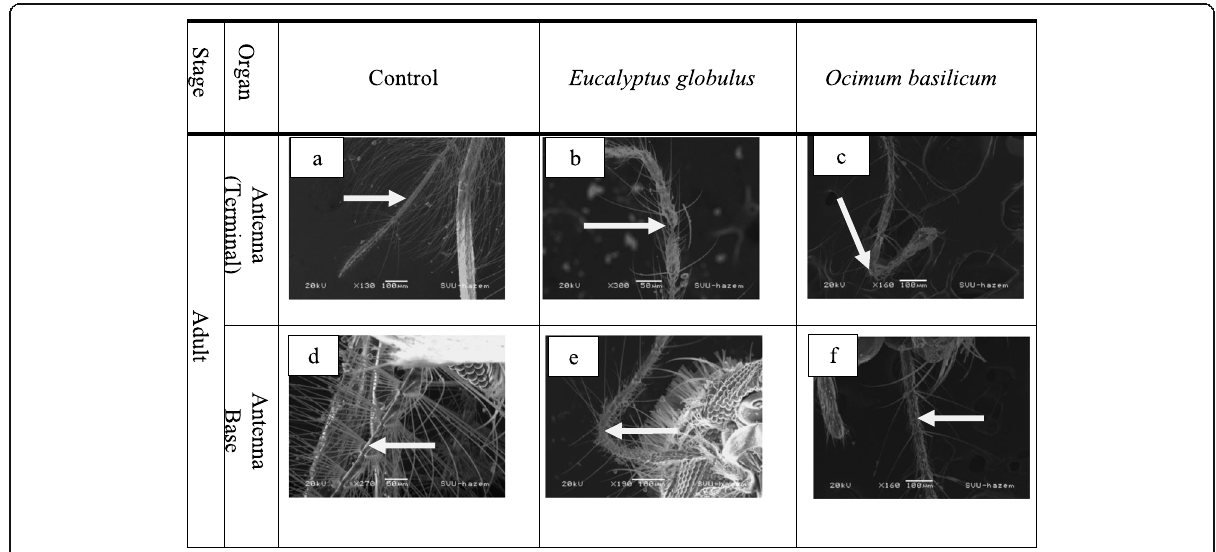
Fig. 4 Scanning electron microscopic (SEM) of adult antennae and mouth parts of Culex pipiens under no smoke and smoke of Eucalyptus globulus and smoke of Ocimum